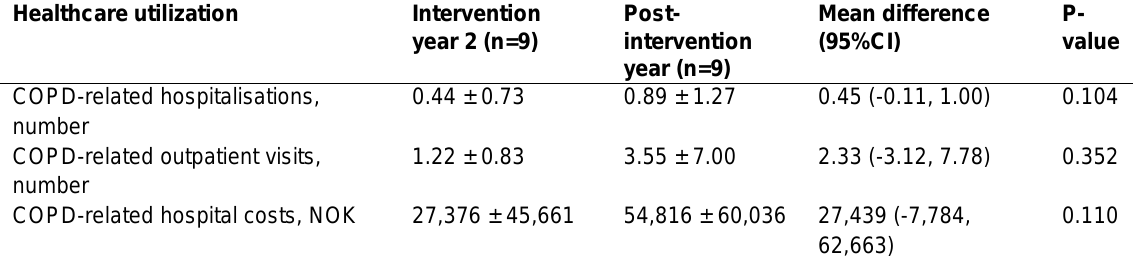
Table 6. Healthcare Utilization (Second Year of the Telerehabilitation vs. Post-intervention Year) Healthcare utilization Intervention